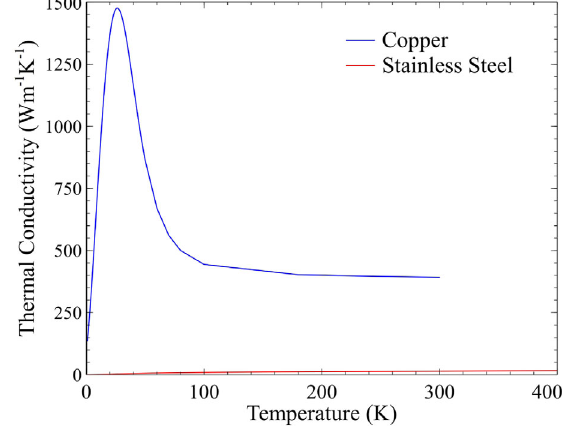
FIG. 3. Variation of thermal conductivities of copper and stainless steel with temperature.